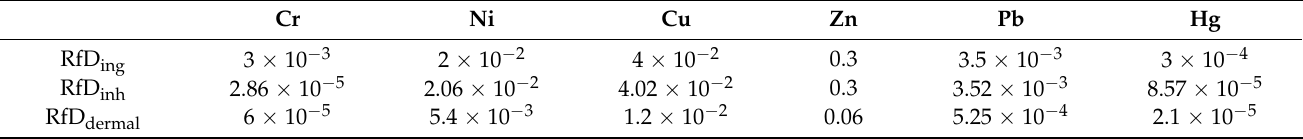
Table 5. Reference dose (mg/kg/day) for different heavy